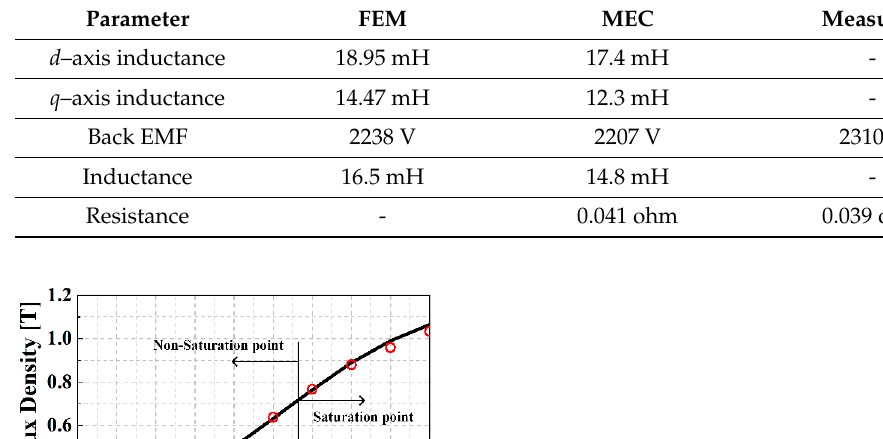
Table 2. FEM and MEC results of electrical parameter (Field current: 215 A).